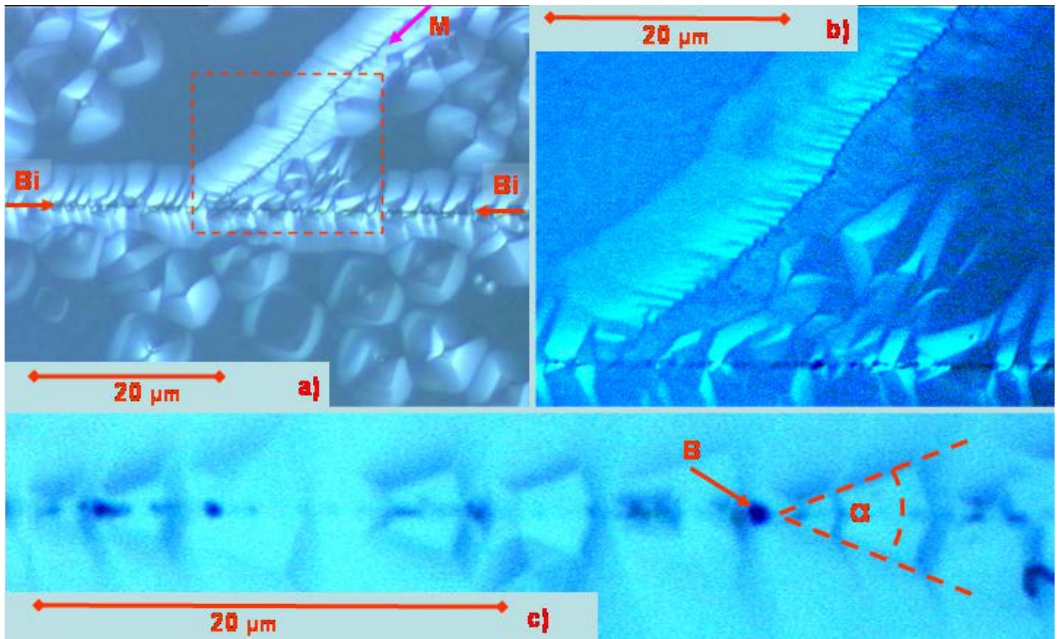
Figure 14. Optical photographs of etched SrTiO 3 bicrystal (boundary 36.8°). ( a , b ) (zoom) show the arrangement of etch pits along of the bicrystalline boundary (Bi) and a similar grouping of etch pits along of the boundary between mosaic structures (M). It should be noted that the distribution of etch pits along of the “native” boundary (M) is much more regular than for the “artificial” (Bi). Optical photography ( c )) with maximal optical magnifications of etch pits along of the bicrystalline boundary present the variations of the shape of the pits and their irregular distribution. The local angle ( α ) which can be determined from the inclination of the etch pits along of the boundary is not the same and can vary for different etch pits from 32° to 38°. Using the adjustment of the focus of the microscope it can be clearly verified that the dark spots along of the boundary (B) lie deeper than the bottom of the etch pits. There are exits of the bundle of dislocations.